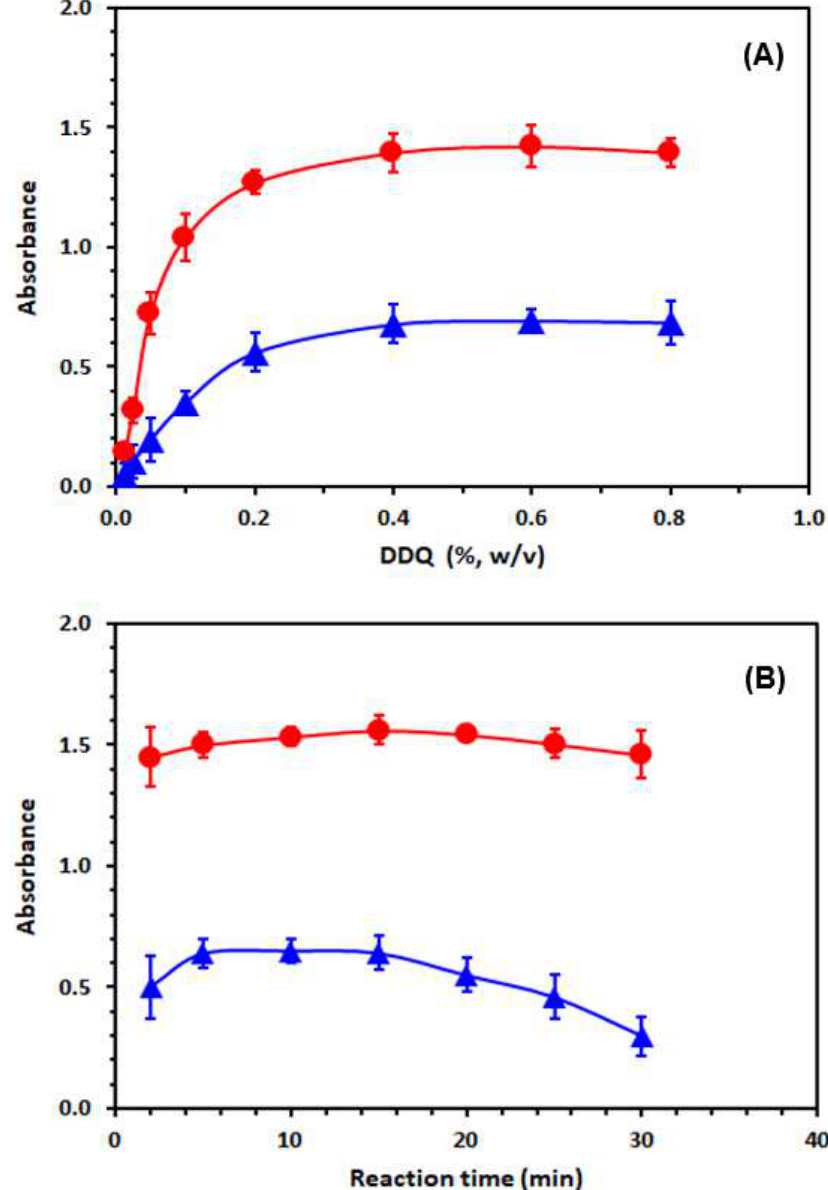
Figure 5. Effect of DDQ concentrations ( A ) and reaction time ( B ) on its reaction with DUV ( (cid:78) ) and SEL ( • ). Concentrations of DUV and SEL in their mixtures were 150 µ g/well (100 µ L). All solutions were in methanol.